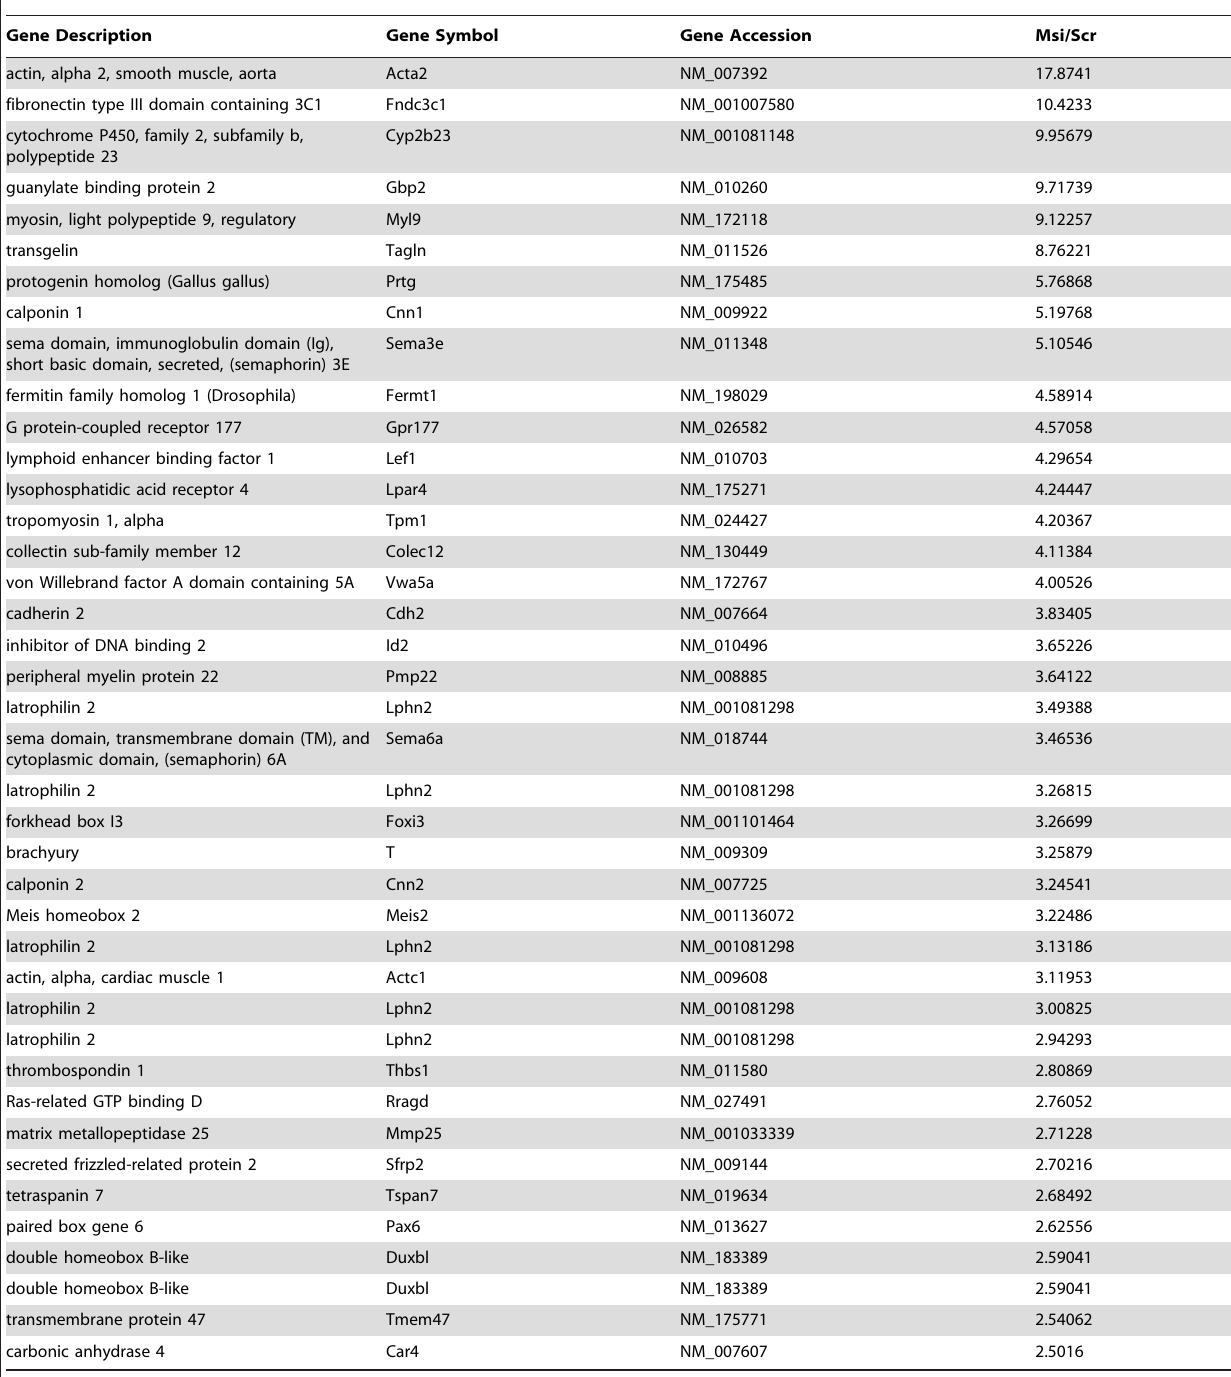
Table 1. Genes more highly expressed ( . 2.5-fold) in Msi2-shRNA # 1 treated ESC.